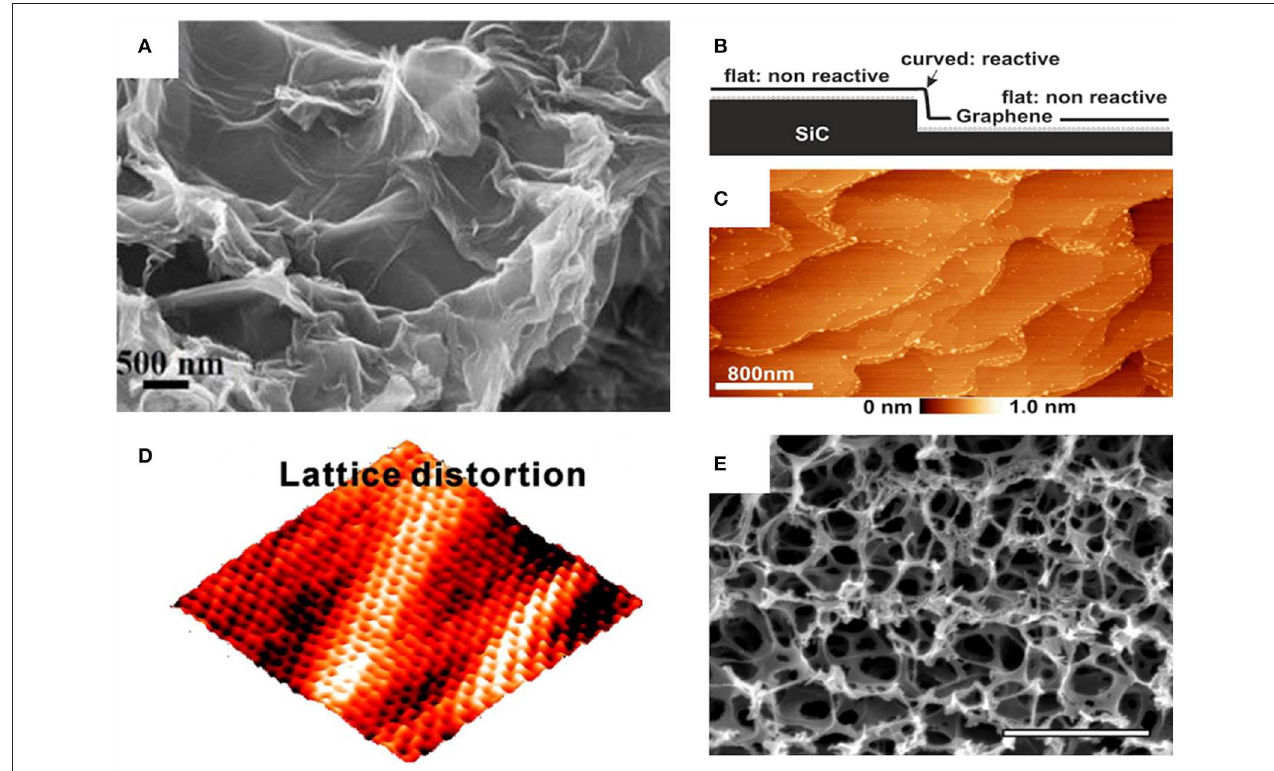
FIGURE 3 | (A) A SEM image of rGO with highly wrinkled morphology. (B) A measuring setup to characterize the large graphene terraces at ambient conditions. (C) An AFM image of graphene. The high spots indicate reactive edges. (D) A 3D STM image of graphene which demonstrates the clear lattice distortions. (E) A SEM image of nano-porous graphene for the determination of pore size and pore size distribution. (A) Reproduced under a Creative Commons Attribution (CC BY-NC-ND 3.0) license from Chabot et al. (2013). (B,C) Reprinted with permission from Wastl et al. (2014). Copyright (2014) American Chemical Society. (D) Reprinted with permission from Zhang et al. (2011). Copyright (2011) American Chemical Society. (E) Reproduced and adapted under a Creative Commons Attribution (CC BY 4.0) license from Lu et al.